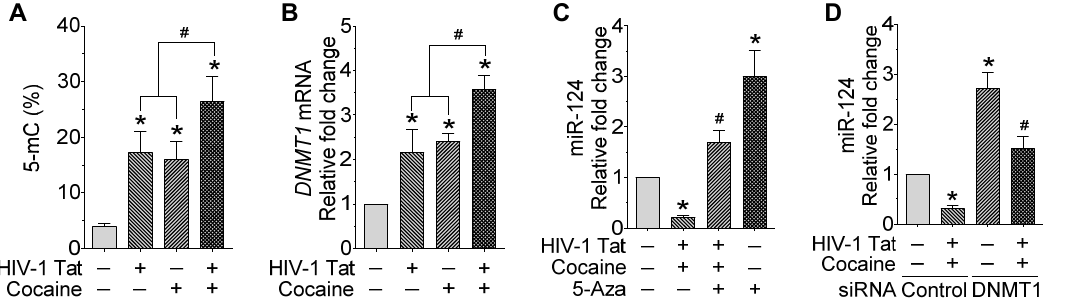
Figure 2. HIV-1 Tat and cocaine significantly increased the global methylation and DNMT1 levels in mouse primary microglial cells. ( A ) Quantification of 5-mC using ELISA in HIV-1 Tat (25 ng/mL) and cocaine (10 μ M) exposed mouse primary microglial cells for 24 h. ( B ) Representative qPCR analysis showing the expression of DNMT1 mRNA in HIV-1 Tat (25 ng/mL) and cocaine (10 μ M) exposed mouse primary microglial cells for 24 h. ( C ) Representative qPCR analysis showing the expression of miR-124 in mouse primary microglial cells pretreated with 5-Aza (5 μ M) followed by HIV-1 Tat (25 ng/mL) and cocaine (10 μ M) exposure for 24 h. ( D ) Representative qPCR analysis showing the expression of miR-124 in DNMT1 gene silenced mouse primary microglial cells exposed with HIV-1 Tat (25 ng/mL) and cocaine (10 μ M) for 24 h. Data are mean ± SEM from six independent experiments. Nonparametric Kruskal–Wallis one-way ANOVA followed by Dunn’s post hoc test was used to determine the statistical significance of multiple groups. * p < 0.05 versus control; # p < 0.05 versus HIV-1 Tat or cocaine.